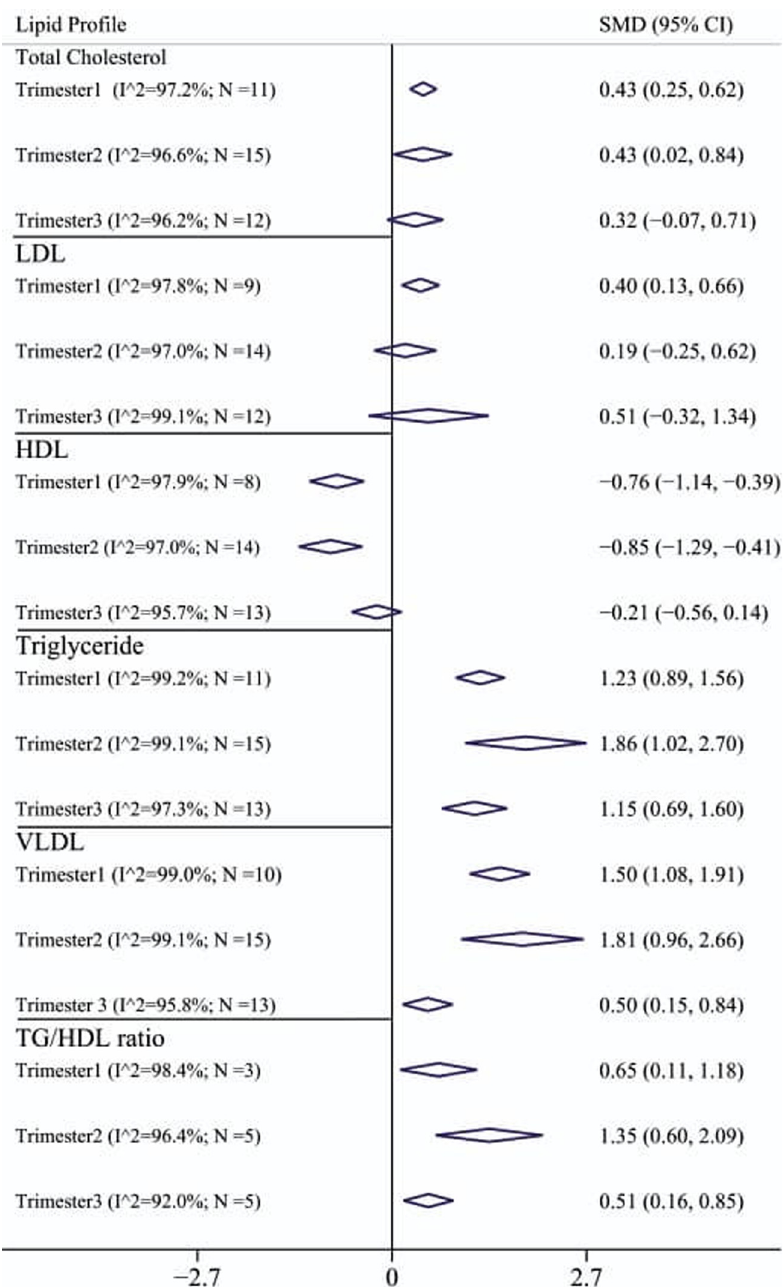
Figure 3: Pooled SMD and 95% con fi dence interval of lipid pro fi le based on di ff erent